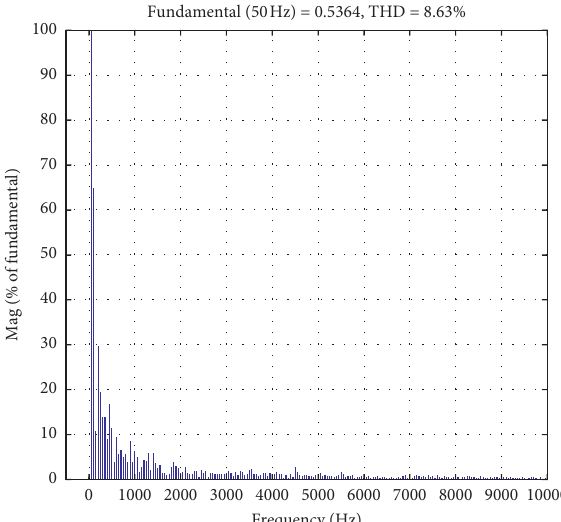
Figure 12: Spectrum analysis of electromagnetic torque using only the full-order observer.